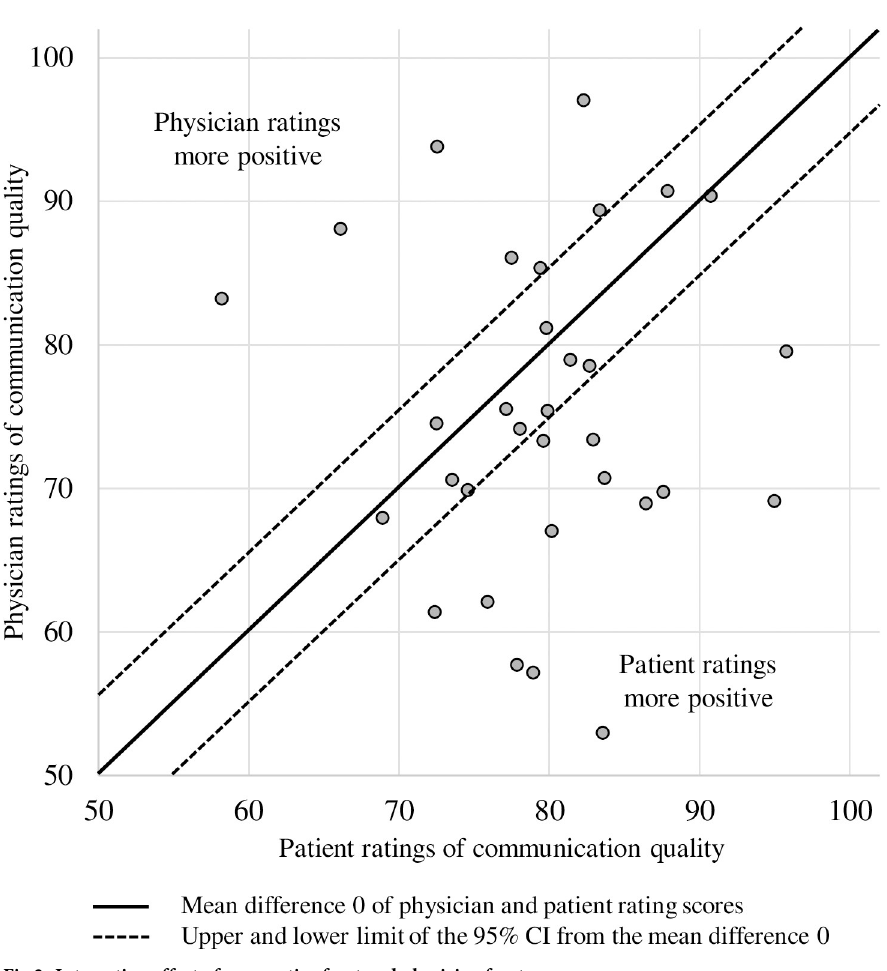
Fig 2. Interaction effect of perspective facet and physician facet.